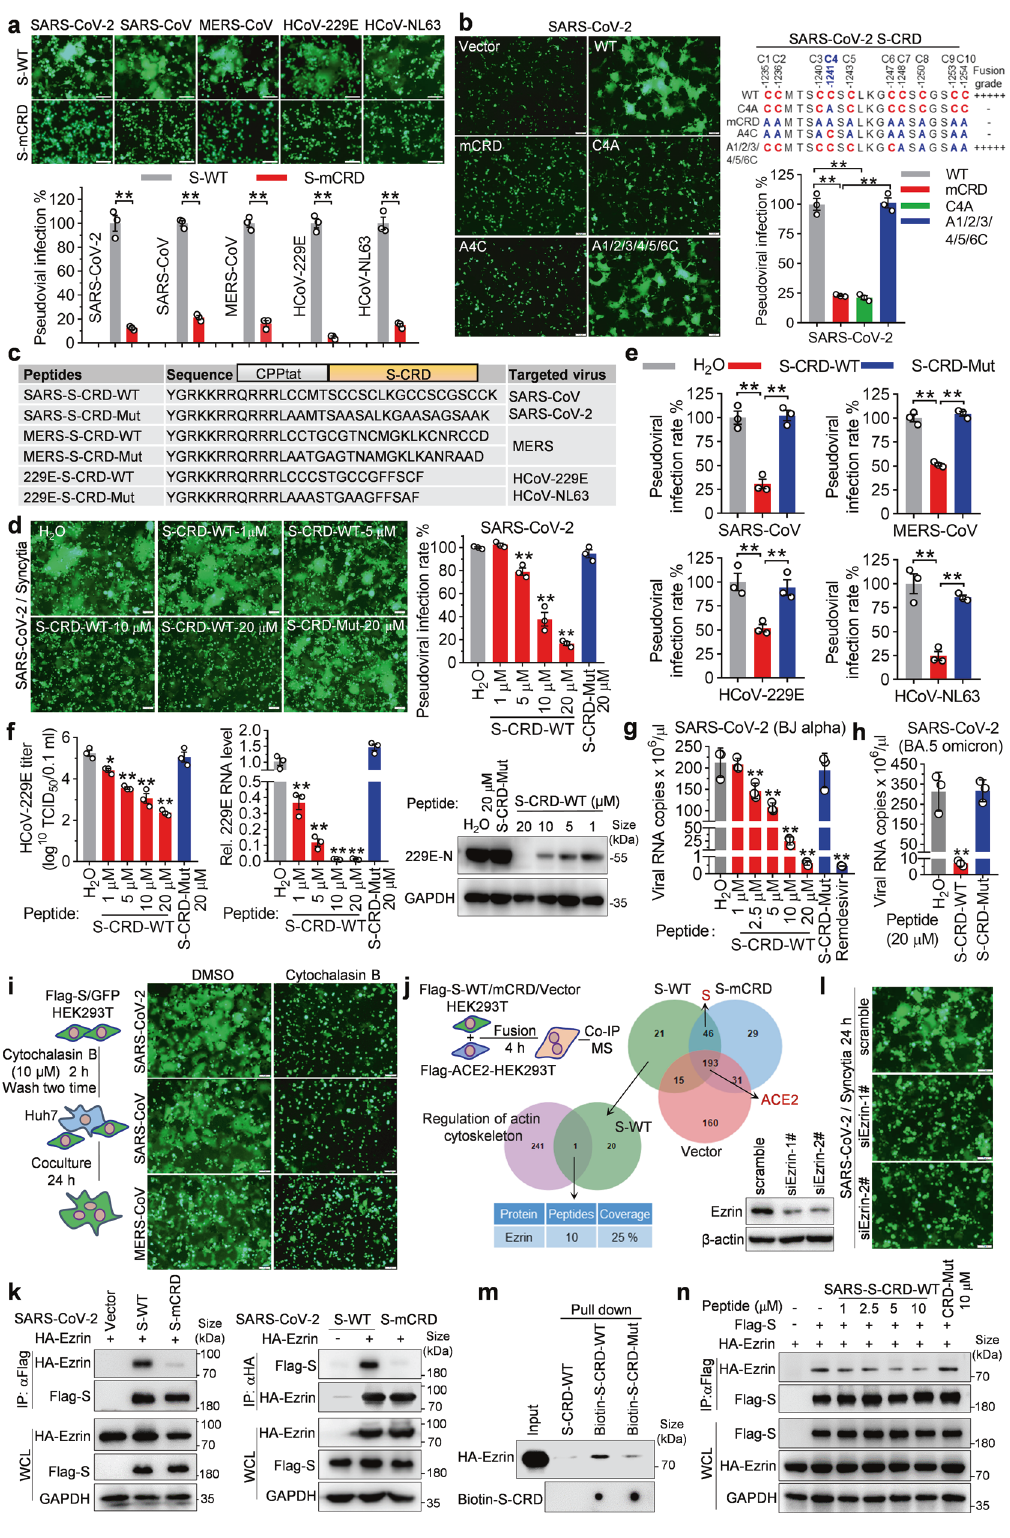
CRD-WT peptide signi fi cantly reduced HCoV-229E titer, cellular viral RNA, and N protein levels in a dose-dependent manner and the IC 50 value on inhibiting HCoV-229E titer was about 1.3 μ M. Treatment with 20 μ M S-CRD-WT peptide led to a decrease of 3.0 log 10 TCID 50 in viral titer and a 100-fold decrease of viral RNA